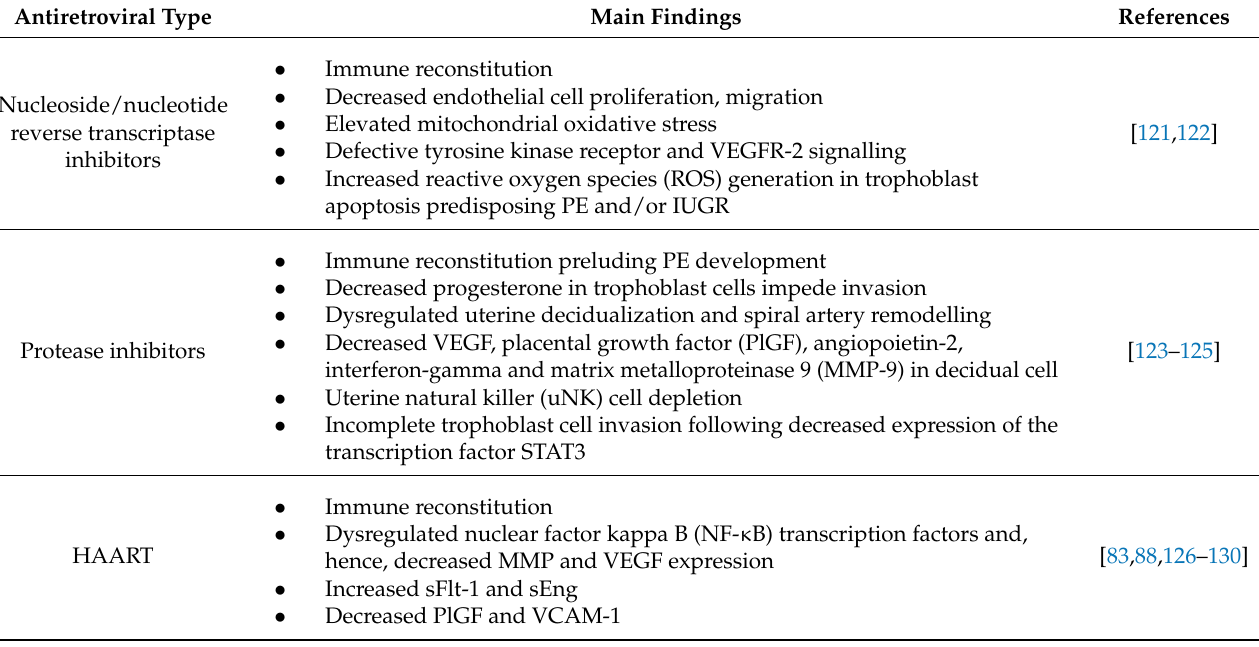
Table 2. Antiretroviral Therapy and HIV associated